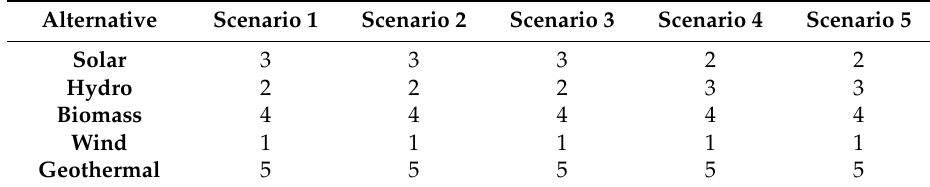
Table 11. Results of the sensitivity